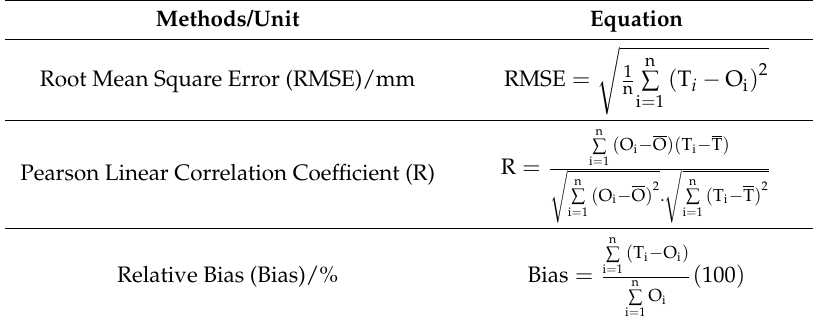
Table 2. Statistical metrics (T = TMPA ‐ 3B43; O = Observed value).